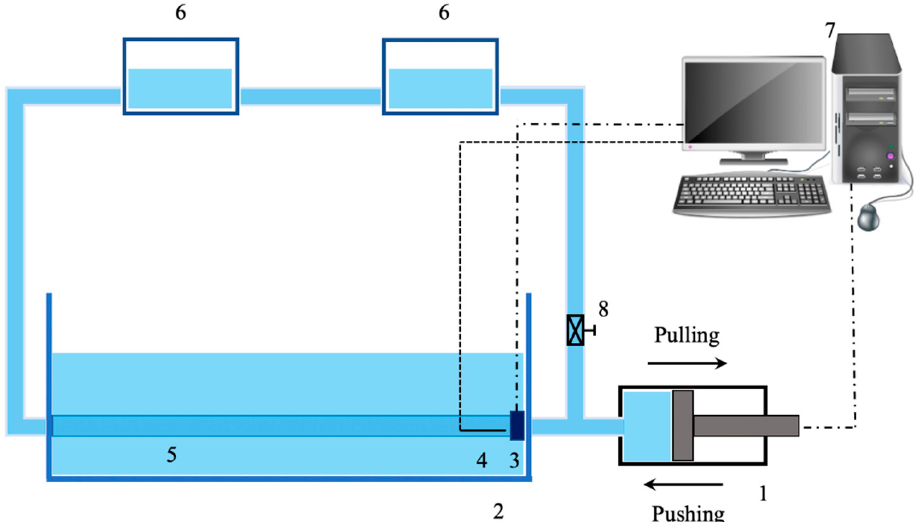
Figure 3. Example of experimental set-up for the study of arterial bifurcation in [45]: (1) piston pump, (2) water tank, (3) flowmeter, (4) pressure catheter, (5) rubber tube, (6) reservoirs, (7) computer, (8) one-way valve.